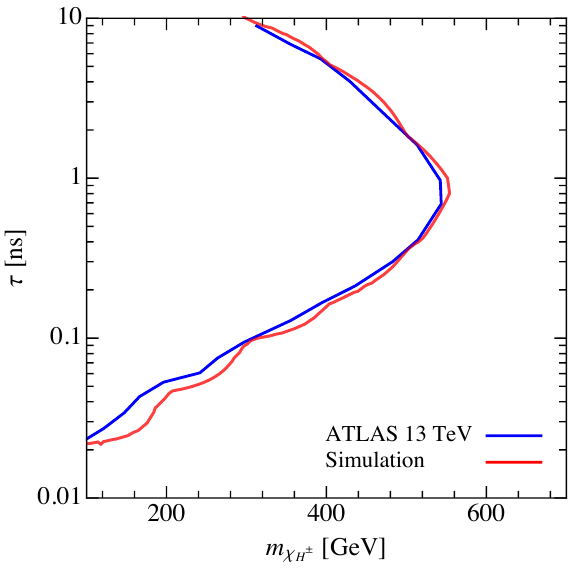
Figure 11 . Limits from disappearing track search as a function of mass and lifetime from the ATLAS 13 TeV result [98] (blue) and from our simulated events with e(cid:14)ciencies applied according to eq. (A.2)